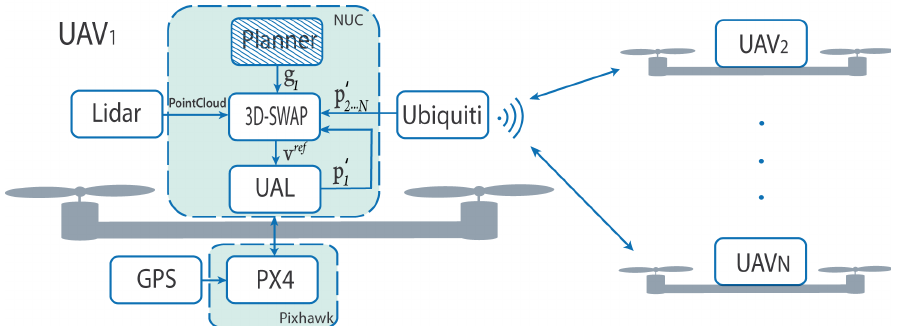
Figure 5. Block diagram of the system integration. Each UAV carries onboard a Pixhawk autopilot with GPS and an Intel NUC to run the navigation software. External obstacles are detected by a Lidar and the Ubiquiti is used as communication channel to share positions with others. The Planner is optional and would provide goals at each moment for the